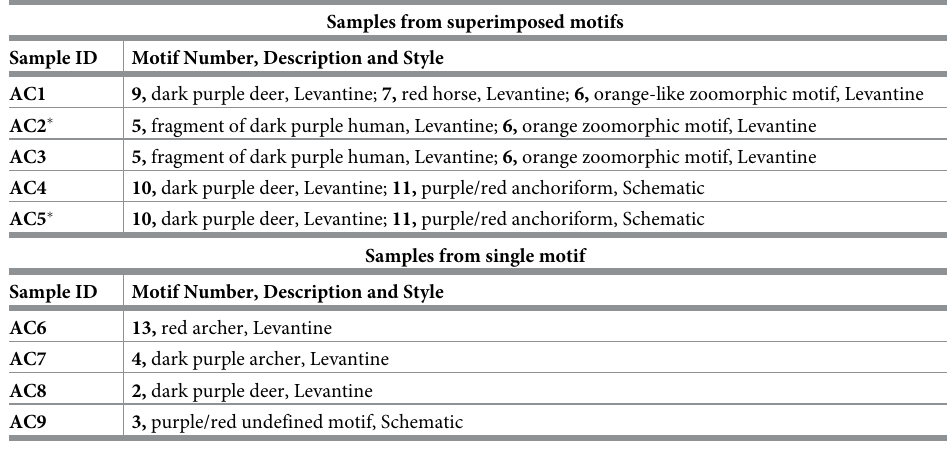
Table 1. List of micro samples collected from the